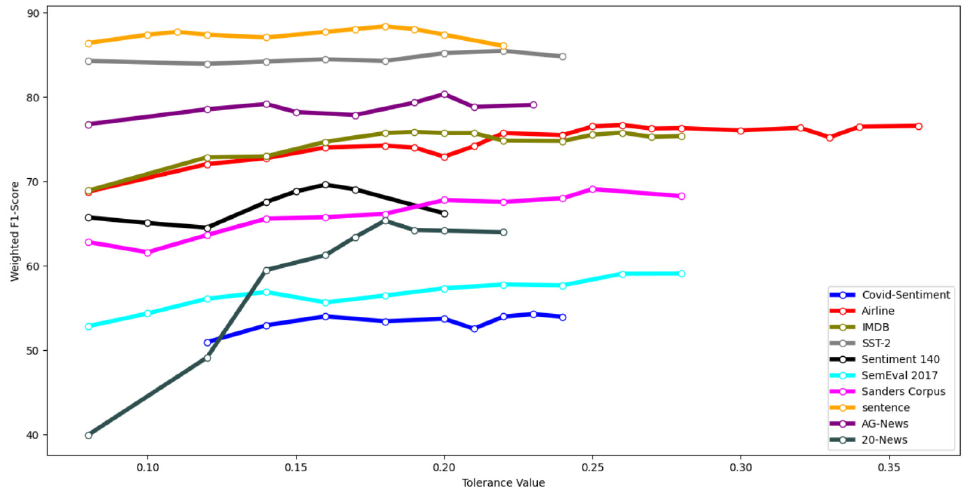
Figure 4. TSC Algorithm: Weighted F1-score for all datasets using median-value (TSC-median) prototype vectors for different ε